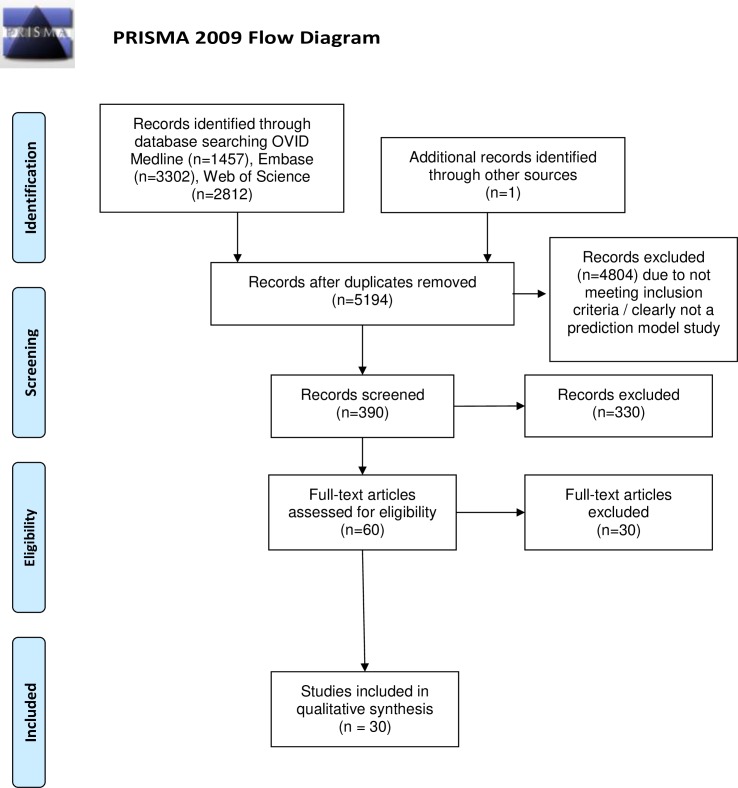
PRISMA flow diagram.